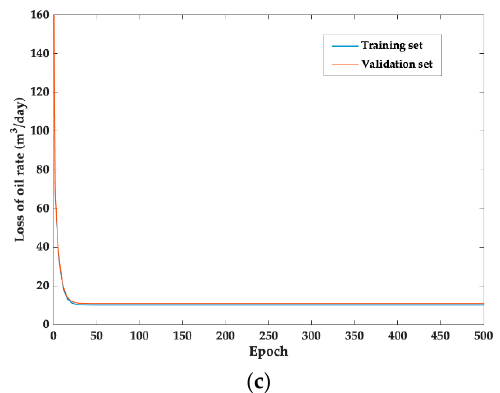
Figure 9. Loss decline curves in training process for pressure and water saturation: ( a ) Loss decline curve for pressure; ( b ) Loss decline curve for water saturation; ( c ) Loss decline curve for oil product.